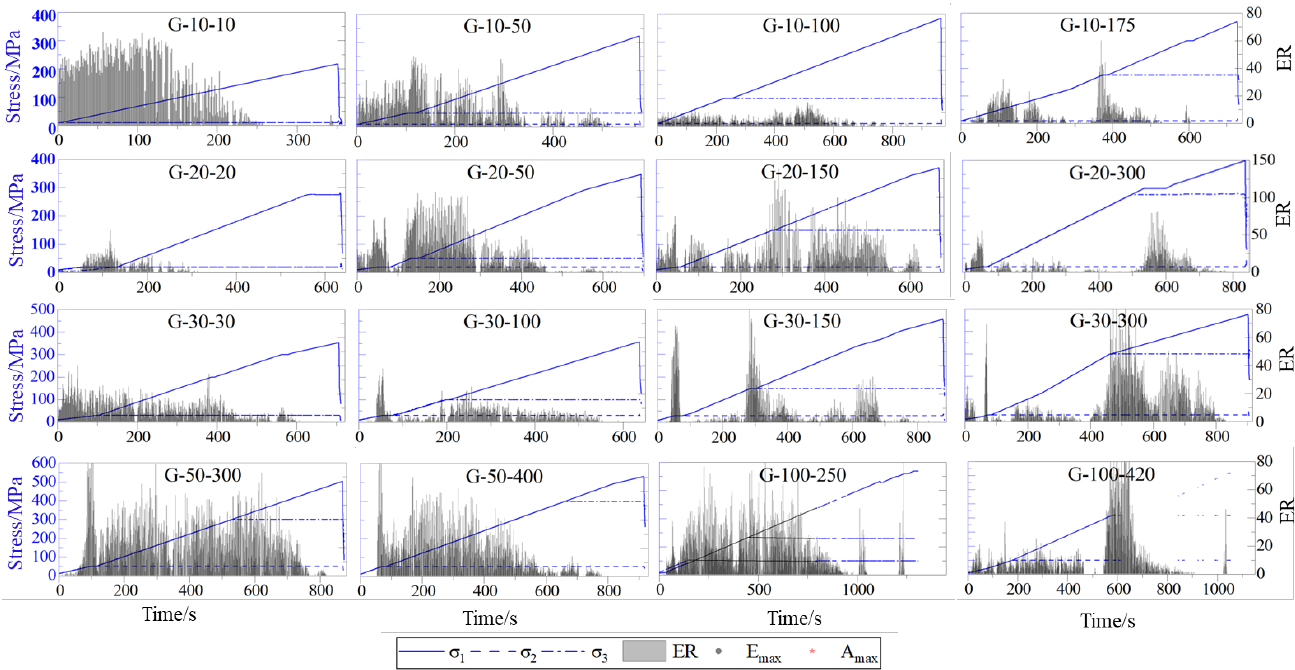
Figure 4. ER, stress vs. time of all specimens in this study. The specimen No. was designed as “G-digit1-digit2”, where “G” represents granite, “digit1” represents the applied stress value of σ 3 , and “digit2” represents the applied stress value of σ 2 ; for example, “G-10-50” means that the applied stress value of σ 3 and σ 2 on this granite specimen are 10 MPa and 50 MPa, respectively. The length of the quiet period is shown in Table 1. When σ 1 reached between 50% and 93% of its peak value, the ER and HR values significantly declined, and AE entered the quiet period. Figure 5 shows the length of the quiet period, and a large dispersion in the distribution of the quiet period can be observed; the duration was from 93 – 452 s, the mean was 239.79 s, and the variance was 114.81. The stress at the beginning of the quiescent period was 27 – 91% of the maximum stress (mean is 69%). Because there is no obvious rule between the length and start time of the quiet period under different stress states, it is difficult to predict rock failure.